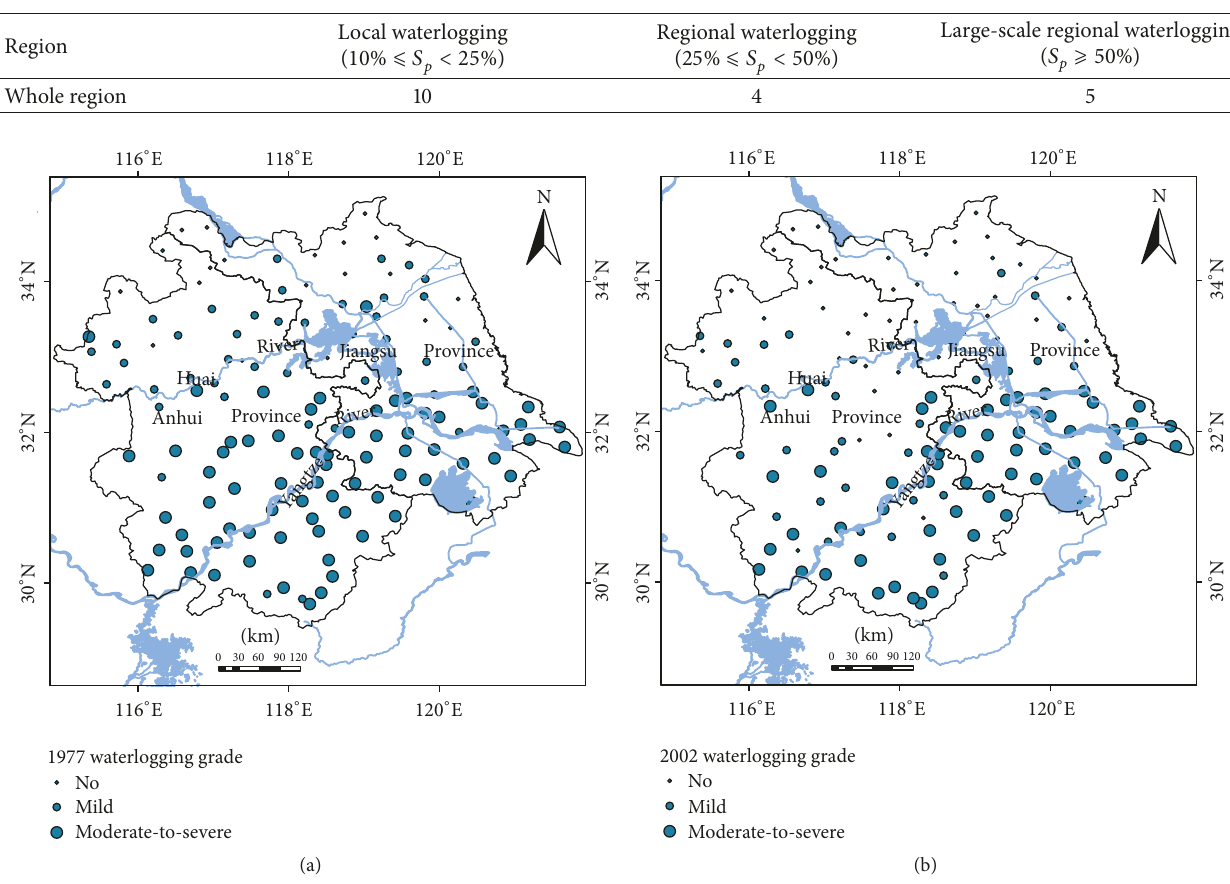
Figure 5: Spatial distribution of waterlogging severity in (a) 1977 and (b)